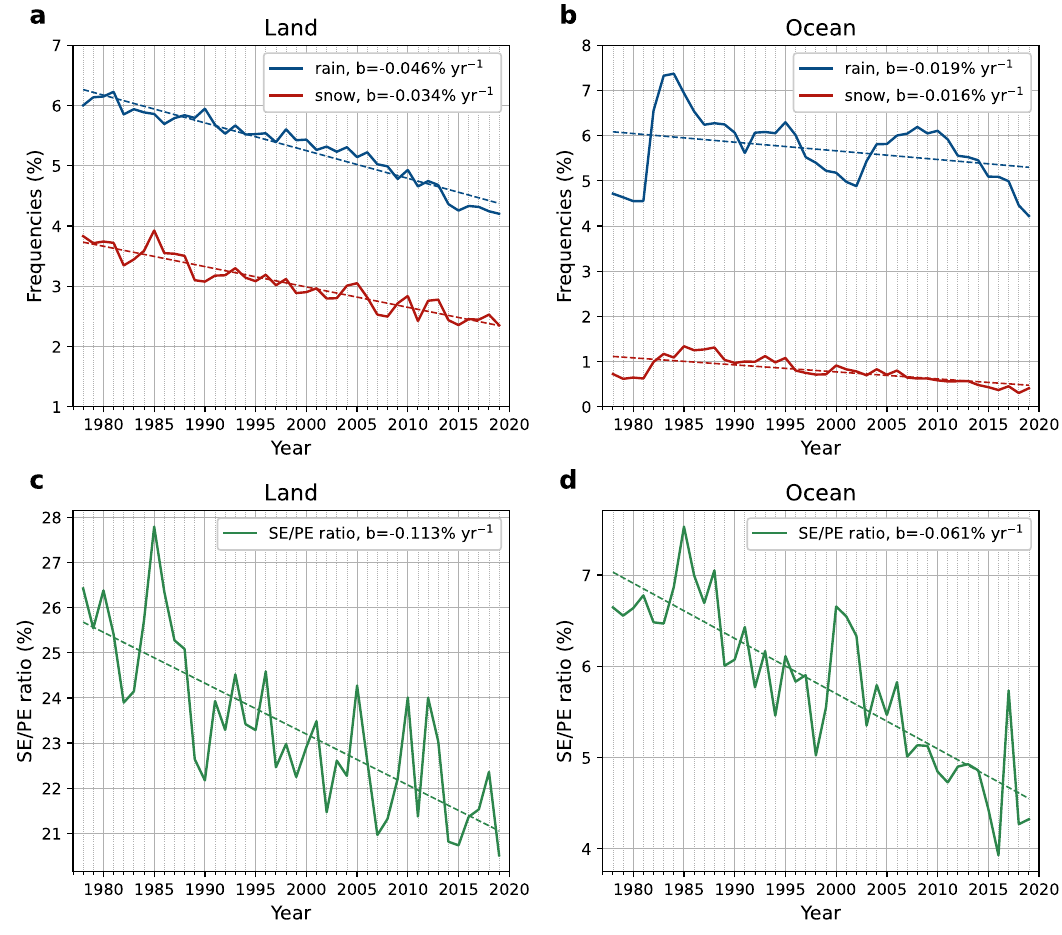
Figure 1. Time evolution of frequencies of rain and snow events. ( a , b ) Frequency of occurrences of rain and snow events averaged over qualified land stations ( a ) or ocean grids ( b ). ( c , d ) Ratio of snow events to precipitation events (SE/PE ratio) averaged over qualified land stations ( c ) or ocean grids ( d ). Linear least squares fitting to the data is applied with slopes shown in the legends as "b" (unit: fraction year −1